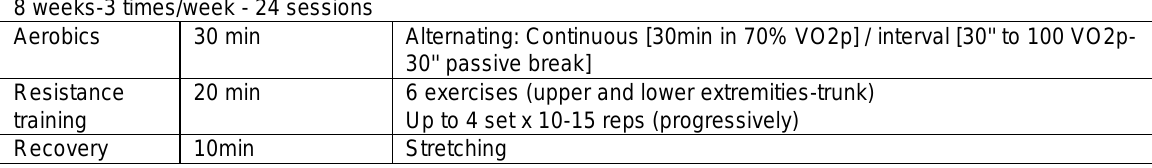
Table 2. Exercise Rehabilitation Program; General Components 8 weeks-3 times/week - 24 sessions